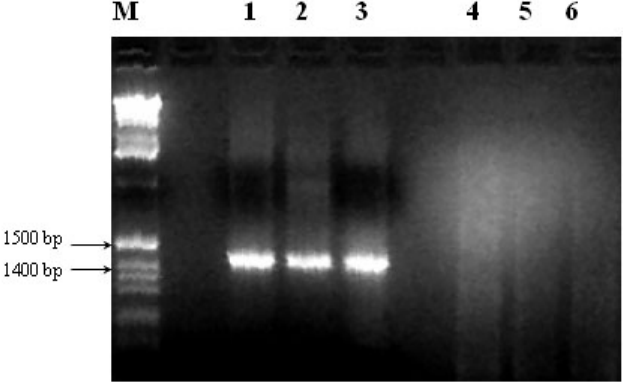
Figure 2. The amplifiability of ATAD DNA extracts from Reactor 2A with two extraction protocols using primers 27 f − 1491 r (Table 1) (with expected amplicon size of 1450 bp) analysed via 1% agarose TBE gel electrophoresis, visualised by EtBr. Lane M, 1kb DNA Marker (Invitrogen) (5 μ L per lane), Lanes 1 − 3, MoBIO extracted ATAD DNA. Lanes 4 − 6, Solvent extracted ATAD